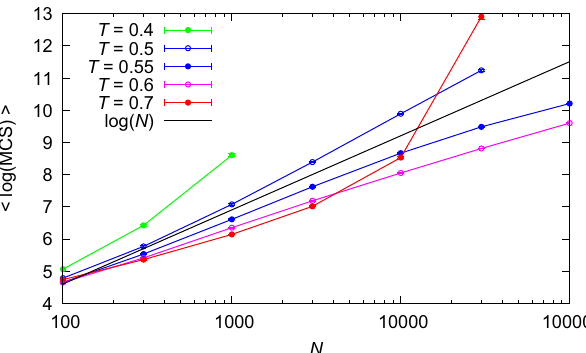
FIG. 12. The mean of the logarithm of the number of MCSs needed by a Glauber dynamics at fixed temperature T to find the planted state in c ¼ 20 coloring